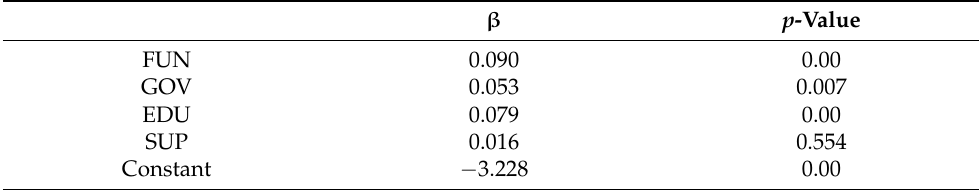
Table 13. Logistic regression results for COM5 (co-operation between the team) independent variable. β